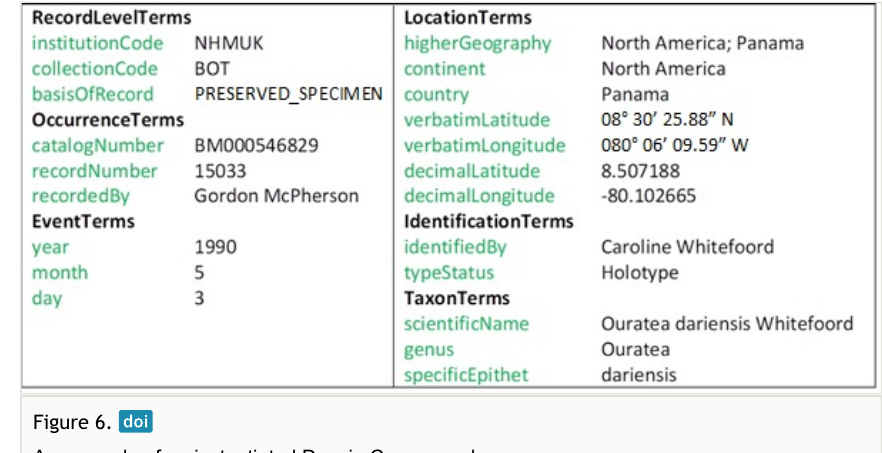
Figure 6. An example of an instantiated Darwin Core